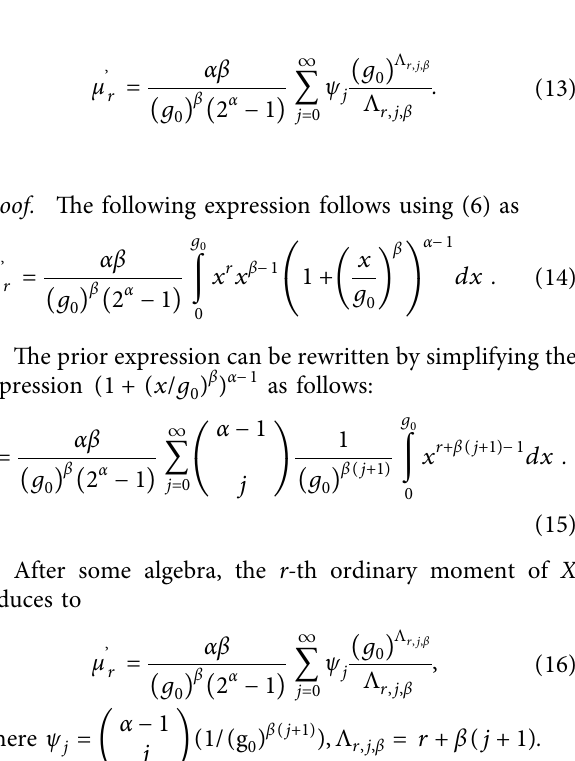
Figure 1: Some curves of PDF for EPF